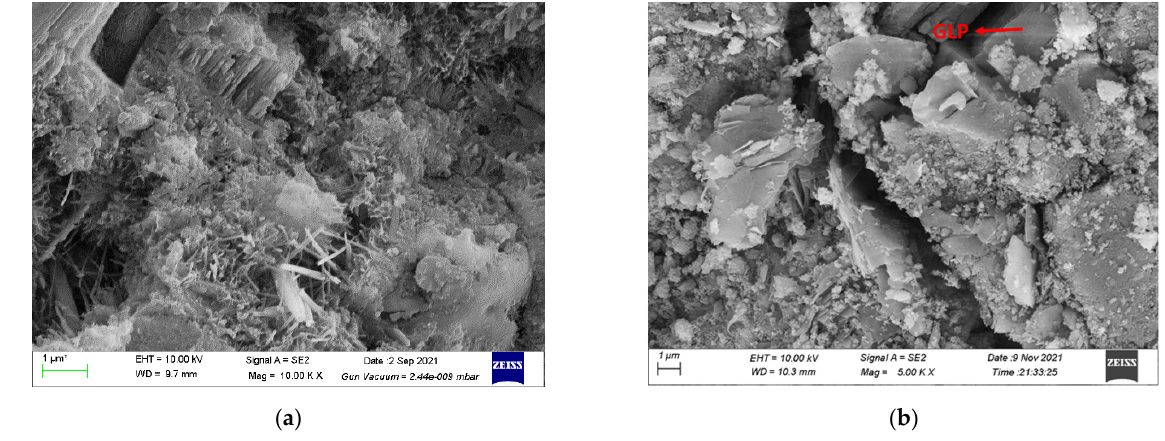
Figure 8. ( a ) Microstructure of white concrete at ( a ) 3 days, and ( b ) 28 days.